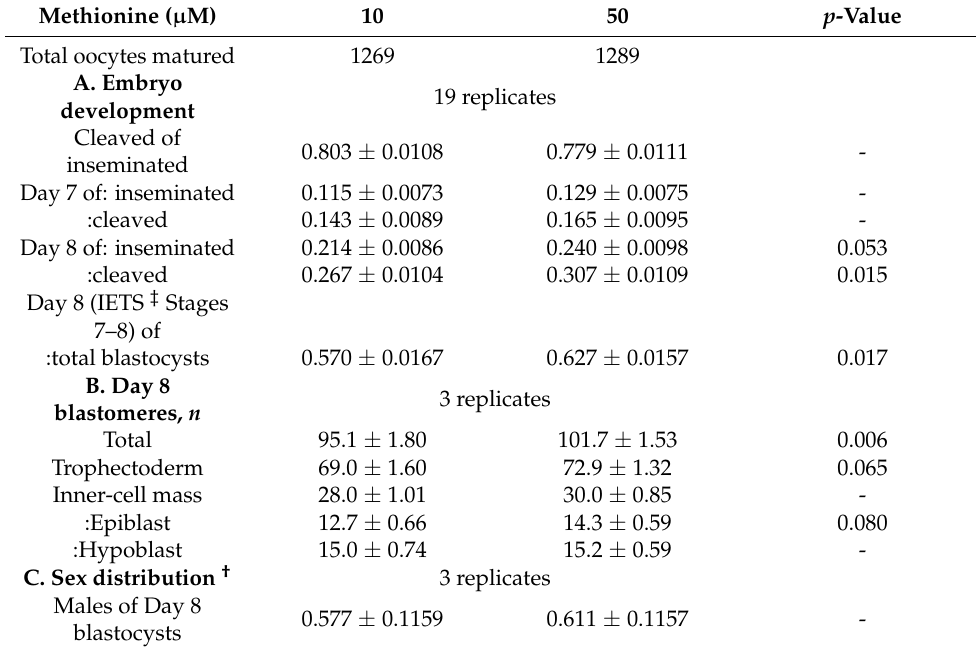
Table 1. Effect of added methionine concentration on bovine in vitro embryo